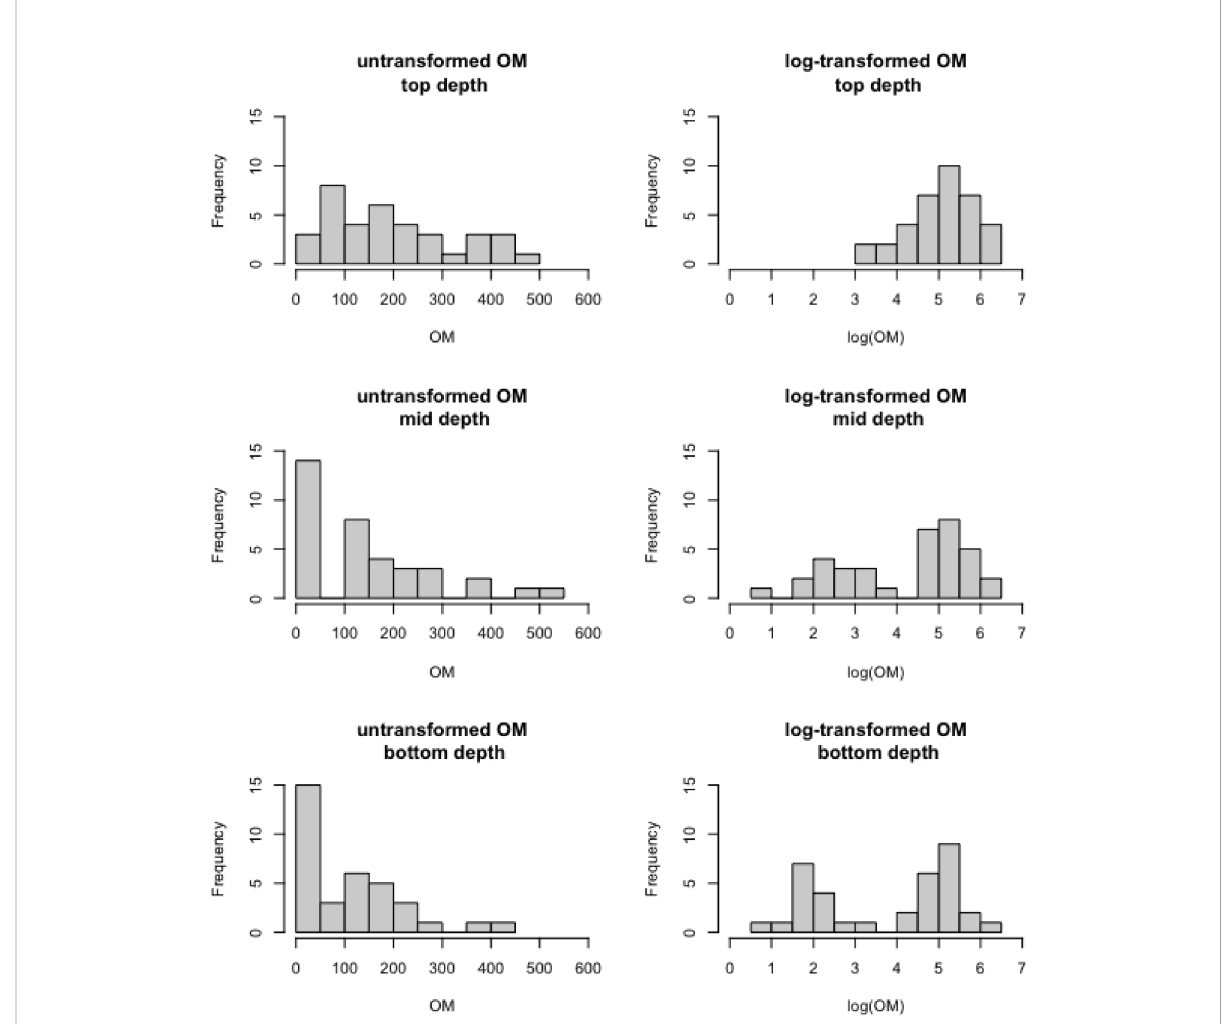
FIGURE 3 Distributions of sediment core organic matter in g/kg soil (left panels) and log(g/kg soil) (right panels) across the 36 marshes observed at the top depth (top panels), middle depth (middle panels), and bottom depth (bottom panels),